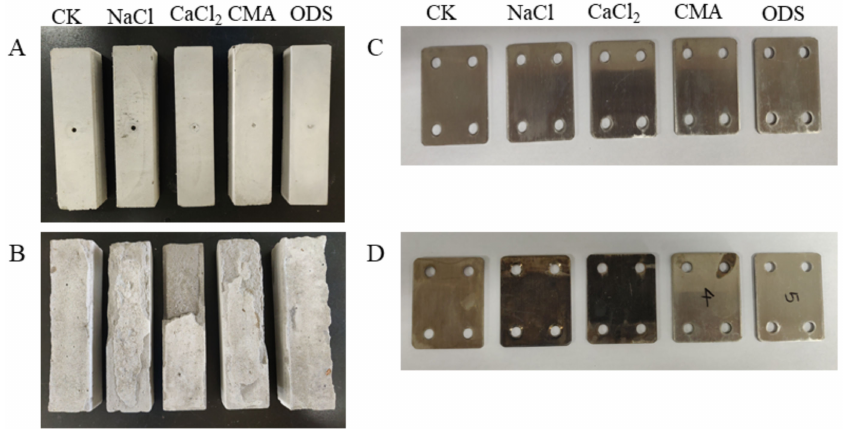
Figure 7. Corrosion of concrete ( A , B ) and carbon steel ( C , D ) with different deicing